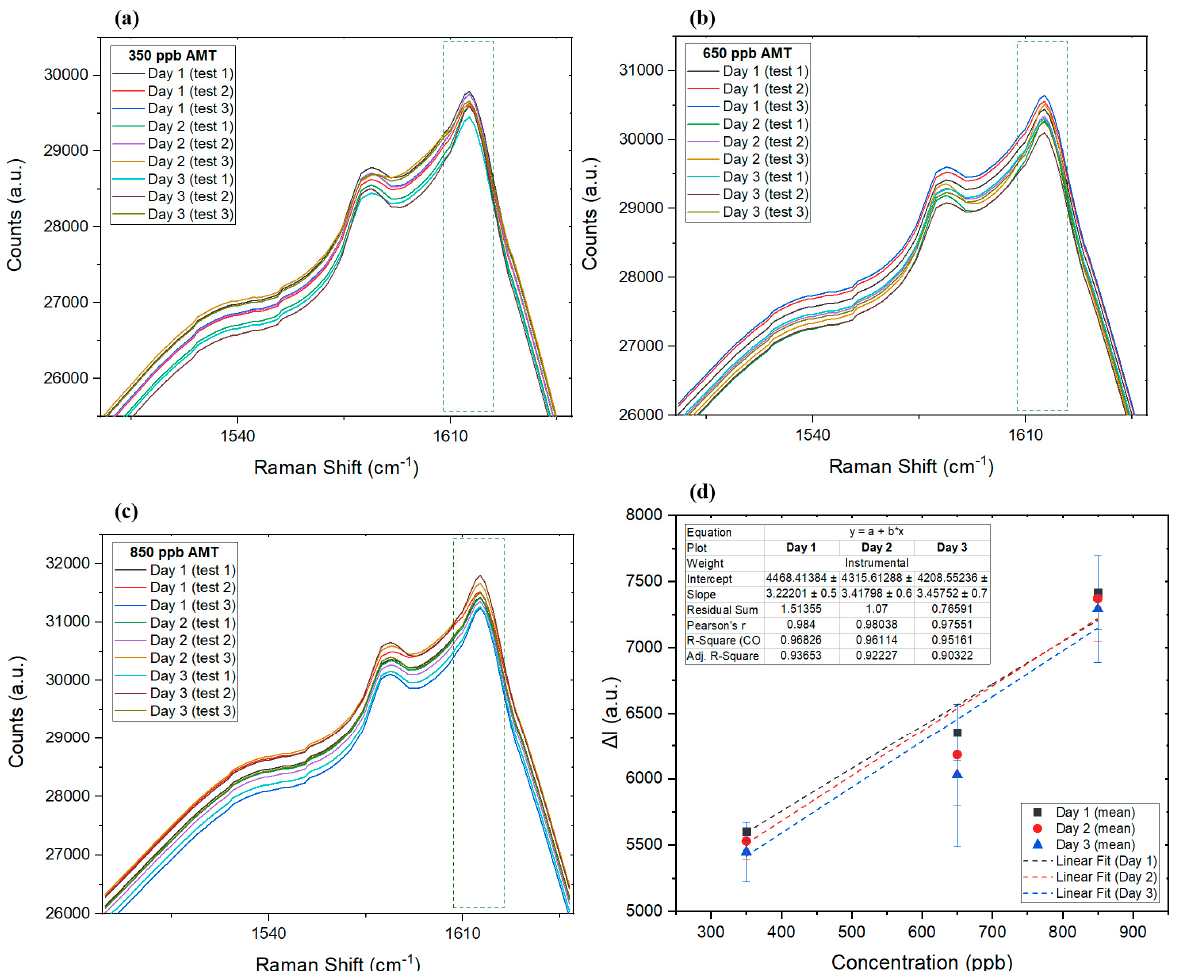
Figure 5. The Raman spectra of the of three tested standard samples of 350 ppb ( a ), 650 ppb ( b ), and 850 ppb ( c ). ( d ) Linear graph for the mean data collected on each day, along with error bars for each day.